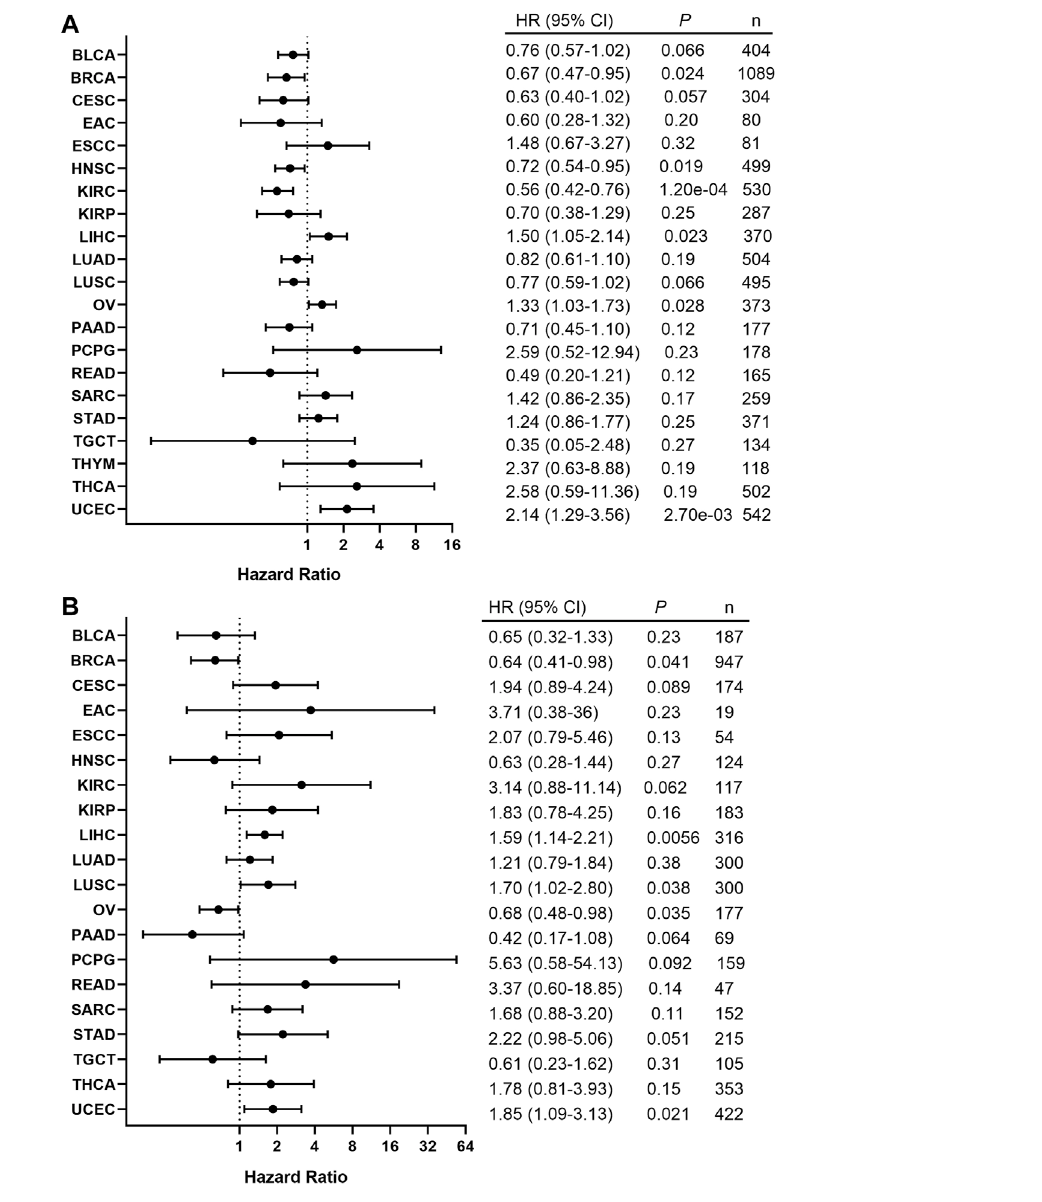
Frontiers in Bioengineering and Biotechnology |